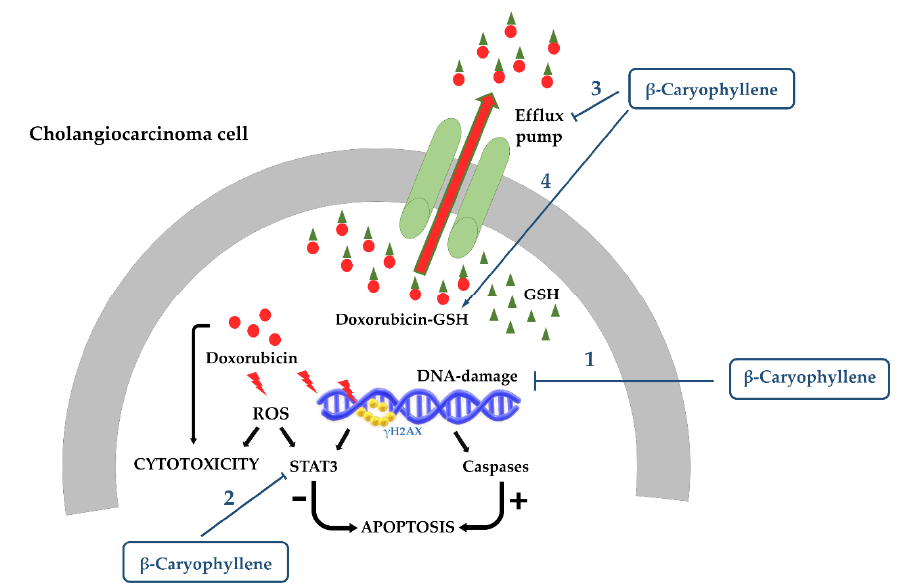
Figure 8. Possible mechanisms involved in the chemosensitizing effects of β-caryophyllene [163]. Doxorubicin increases reactive oxygen species (ROS) and γH2AX levels, thus leading to S-phase cell cycle arrest and activation of STAT3 as chemoresistance responses; moreover, the drug can be conjugated with glutathione (GSH) and extruded by the efflux pumps. When doxorubicin is administered in combination with β-caryophyllene, the sesquiterpene stimulates cell cycle checkpoints (both G0/G1 and G2/M phases), partly lowers DNA damage (1), and inhibits the STAT3 activation (2), thus increasing the apoptosis rate. Moreover, it can block the efflux pumps (3), thus allowing the intracellular accumulation of doxorubicin–GSH conjugates (4), which in turn lead to cytotoxic and pro-aptotic effects.